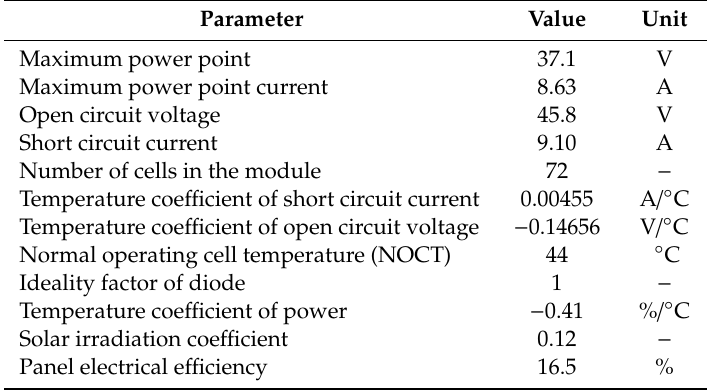
Table 3. PV array specifications.